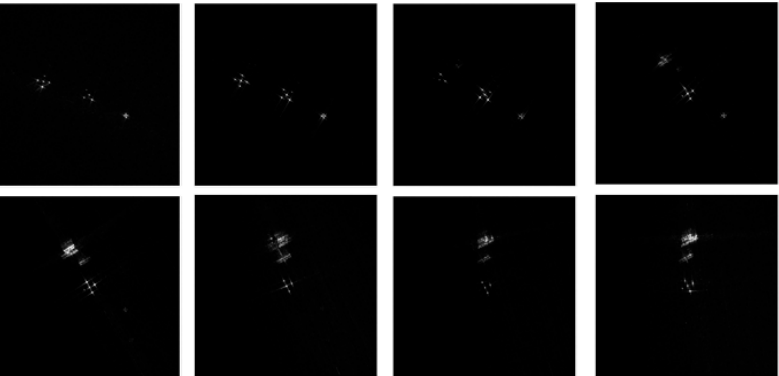
Figure 20. Imaging results of different frames. Indexes of images, from left to right then from up to down, are 1, 26, 51, 76, 101, 126, 151 and 176, respectively.